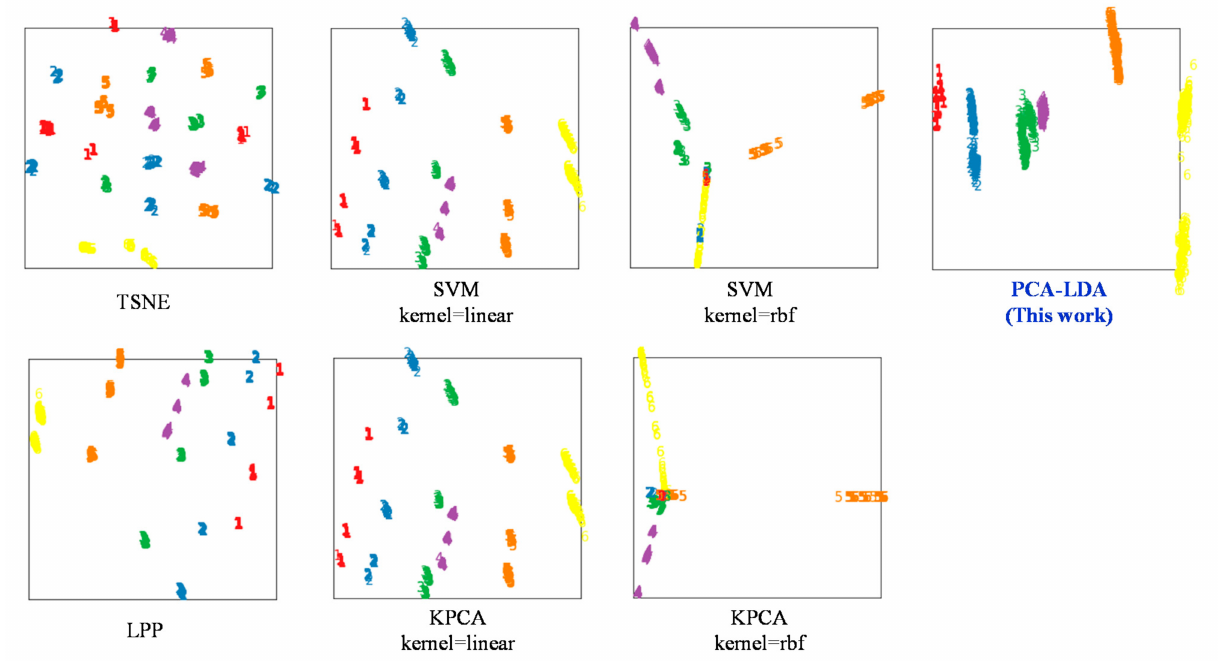
Figure 13. The 2D distribution results of different data dimensionality reduction methods (TSNE, SVM, KPCA, LPP, and this work). The color of each data point depends on the types of